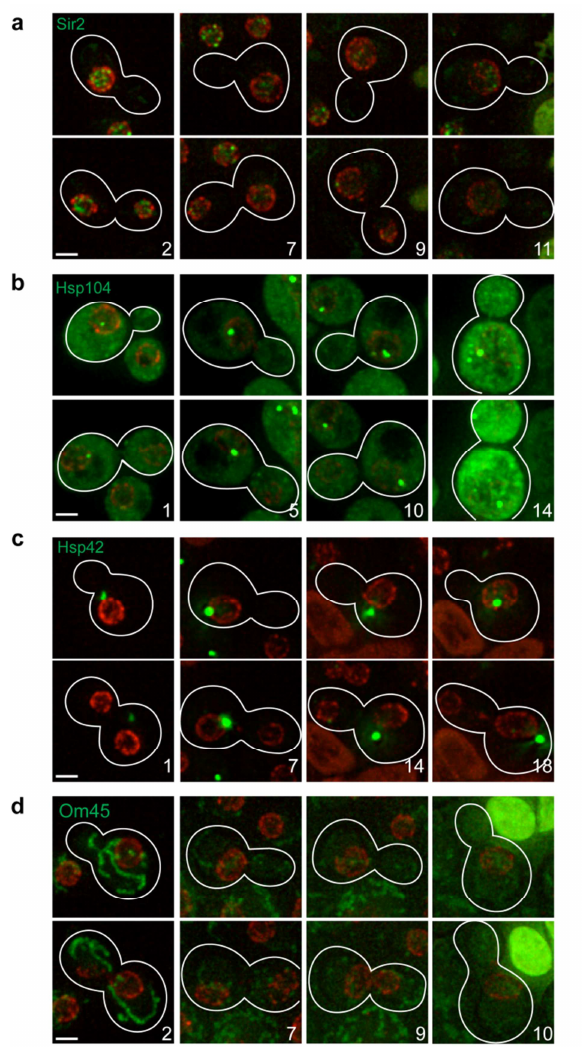
Figure 2: Protein localization changes as cells age. MEP cells expressing Sir2-GFP (a) , Hsp104-GFP (b) , Hsp42-GFP (c) , or Om45- GFP (d) were analysed by time-lapse microscopy. Nup49-mCherry was used as marker of the nuclear periphery. Upper and lower images corresponding to the same division, usually 20-60 min apart, are shown to detect possible cell cycle-dependent changes in localization. Stacks of 8–9 sections (0.4 µm spacing) acquired at different time points were deconvolved (maximal projection is shown). Bright-field images were used to draw cell boundaries and count the number of divisions for the mother cells (age indi- cated with numbers). Representative images are shown. For Sir2- GFP, all six cells analysed showed the same phenotype. For Hsp104-GFP, Hsp42-GFP and Om45-GFP, 10 of 14, 6 of 7 and 11 of 13 cells, respectively, showed the phenotype depicted and described in the text. Scale bar, 2 is not clear if this event is common to the whole population [16]. In agreement with previous results [14], we observed that mitochondria labeled with Om45-GFP fragment show a diffuse staining in old cells in contrast to the typical tubu- lar morphology detectable in young cells (Fig. 2d).